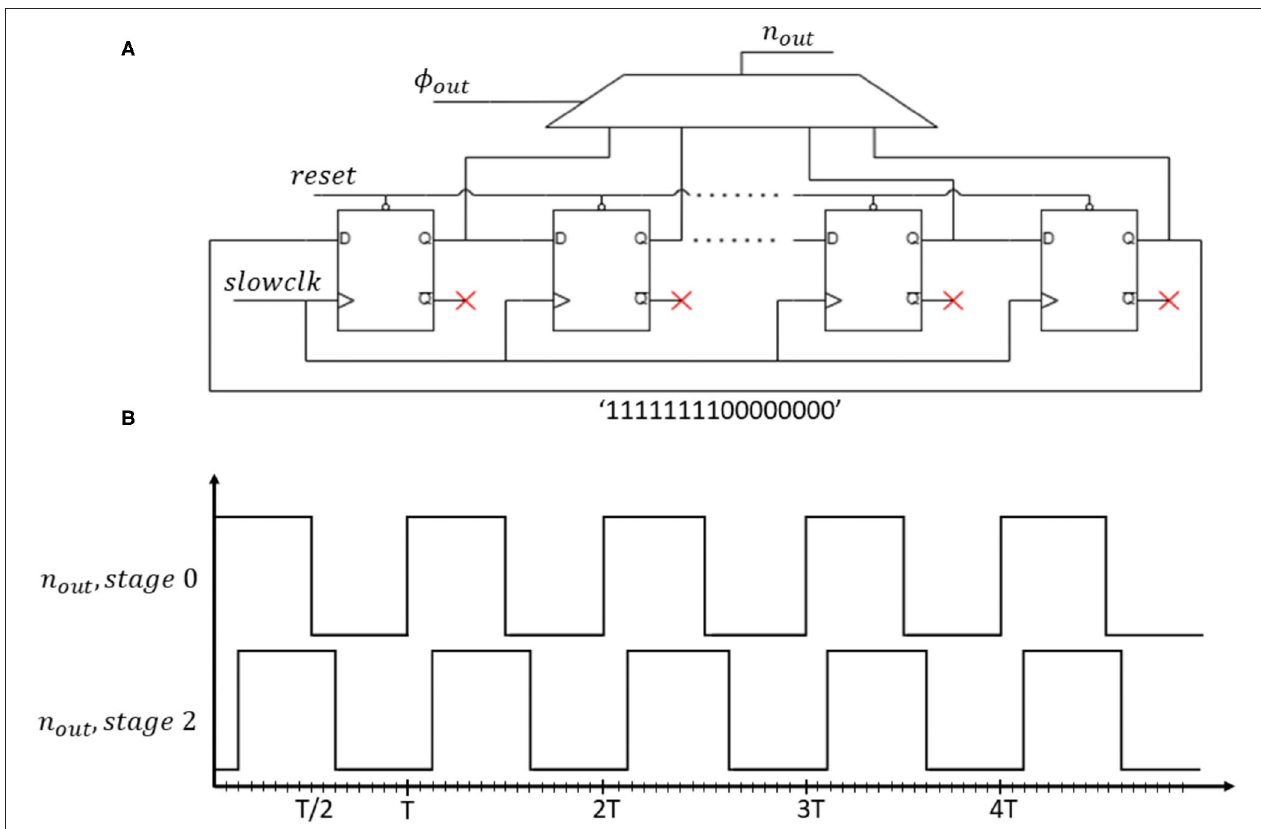
FIGURE 4 | (A) Logic diagram of the implemented phase-controlled oscillator. (B) Output waveform of internal neuron shift-register for stages 0 and 2.